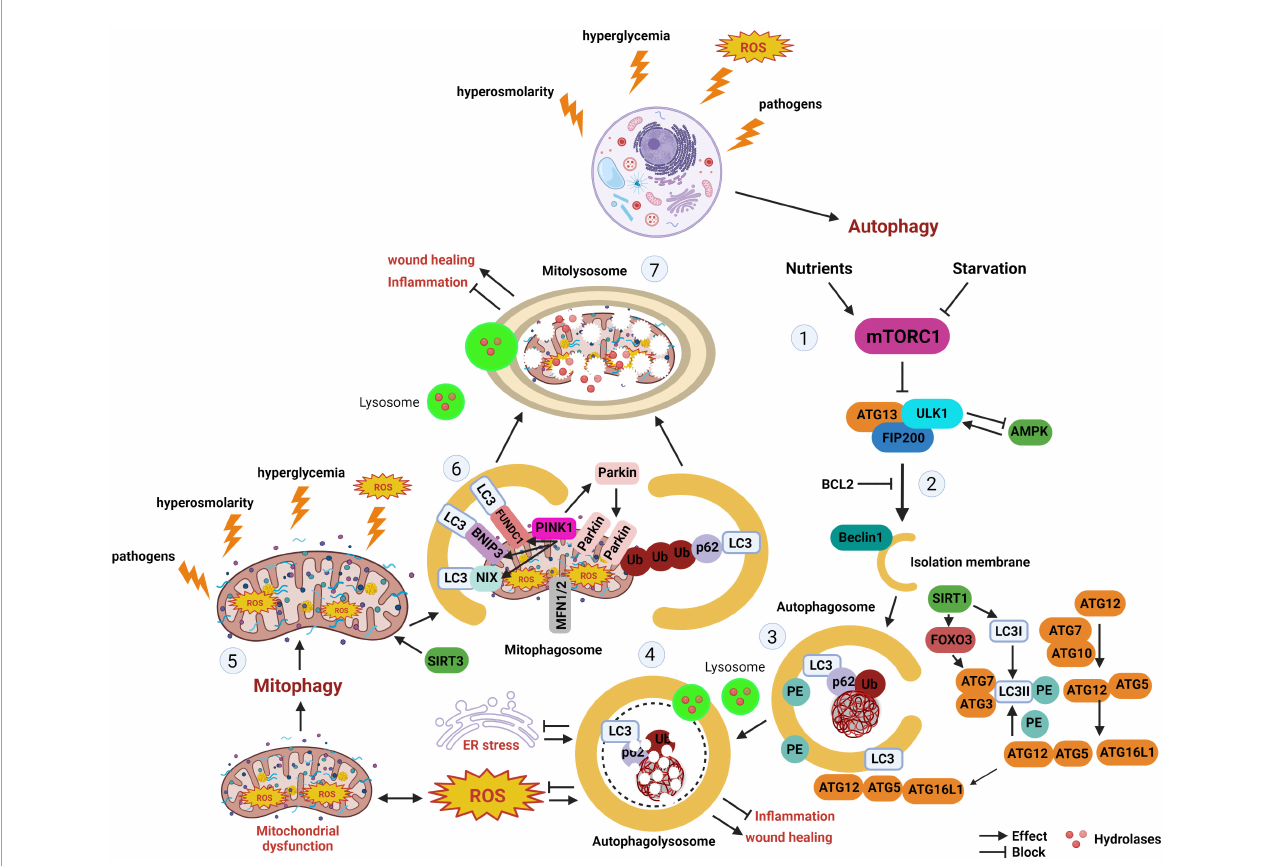
FIGURE1 Autophagy and mitophagy. The stages of autophagy and mitophagy, a selective form of autophagy that clears damaged mitochondria. (Stage 1) Autophagy induction. Nutrient starvation and hyperglycemia differentially regulate mTORC1. During nutrient starvation, AMPK activates ULK1 to induce autophagy. In hyperglycemia, AMPK and SIRT1 inhibits autophagy. (Stage 2) Autophagy nucleation. Beclin 1 is liberated from BCL2, initiating autophagosome nucleation. (Stage 3) Autophagy expansion/completion. LC3II is formed from the association of LC3 with PE. SIRT1 interacts with autophagy proteins ATG5, ATG7, and LC3, as well as FOXO3. The autophagosome undergoes fusion with the lysosome. (Stage 4) Autophagy termination. Mature lysosomes are fused forming autophagolysosomes. Cargo undergoes proteolytic degradation by hydrolases. (Stage 5) Hyperglycemia, hypoxia, ROS, and other factors may activate mitophagy. (Stage 6) Depolarized mitochondria promote the recruitment of PINK1 to the mitochondria. PINK1 accumulation at the outer mitochondrial membrane leads to the recruitment of Parkin. As an E-3 ligase, Parkin promotes polyubiquitination of other proteins, including p62, leading to recognition of LC3 and mitophagosome formation. BNIP3, BNIP3L/NIX, and FUNDC1 are mitophagy receptors with LIR that can directly interact with LC3 on the autophagosome in the absence of PINK1 accumulation. (Stage 7) Like autophagy, mitophagosomes fuse with lysosomes, allowing for damaged mitochondria to undergo degradation by lysosomal enzymes. mTORC1, mechanistic target of rapamycin complex 1; ATG, autophagy related protein; ULK1, Unc-51-like kinase 1; FIP200, focal adhesion kinase family interacting protein; AMPK,